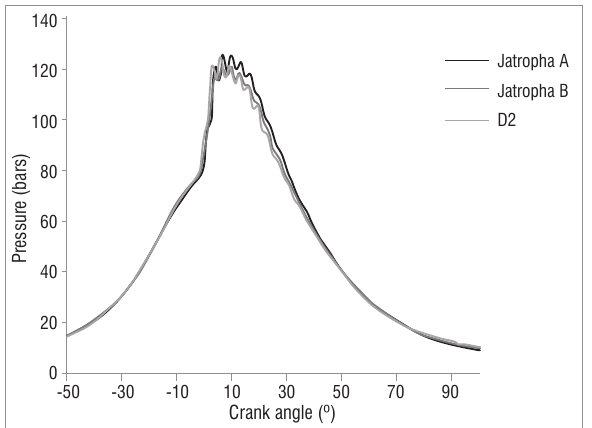
Figure 8: Cylinder pressure variation with crank angle at full load.